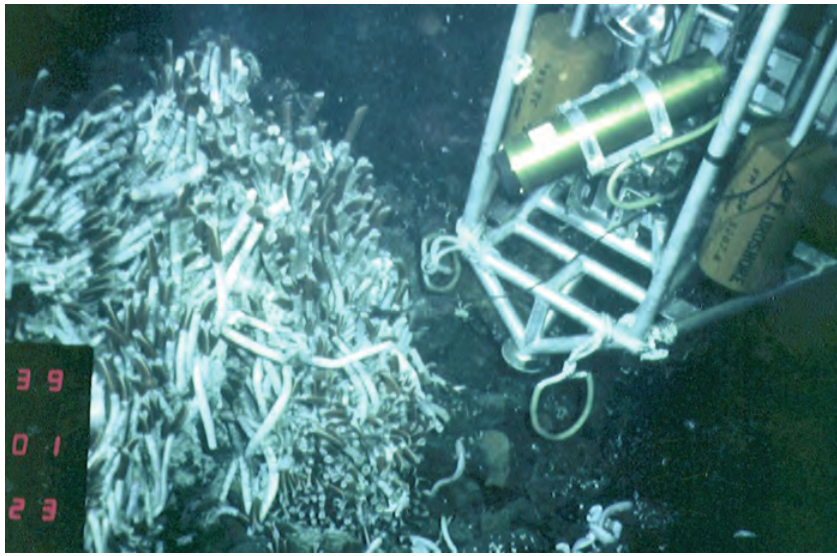
Fig. 4. SAMO is following up the hydrothermal biota with a video camera during some